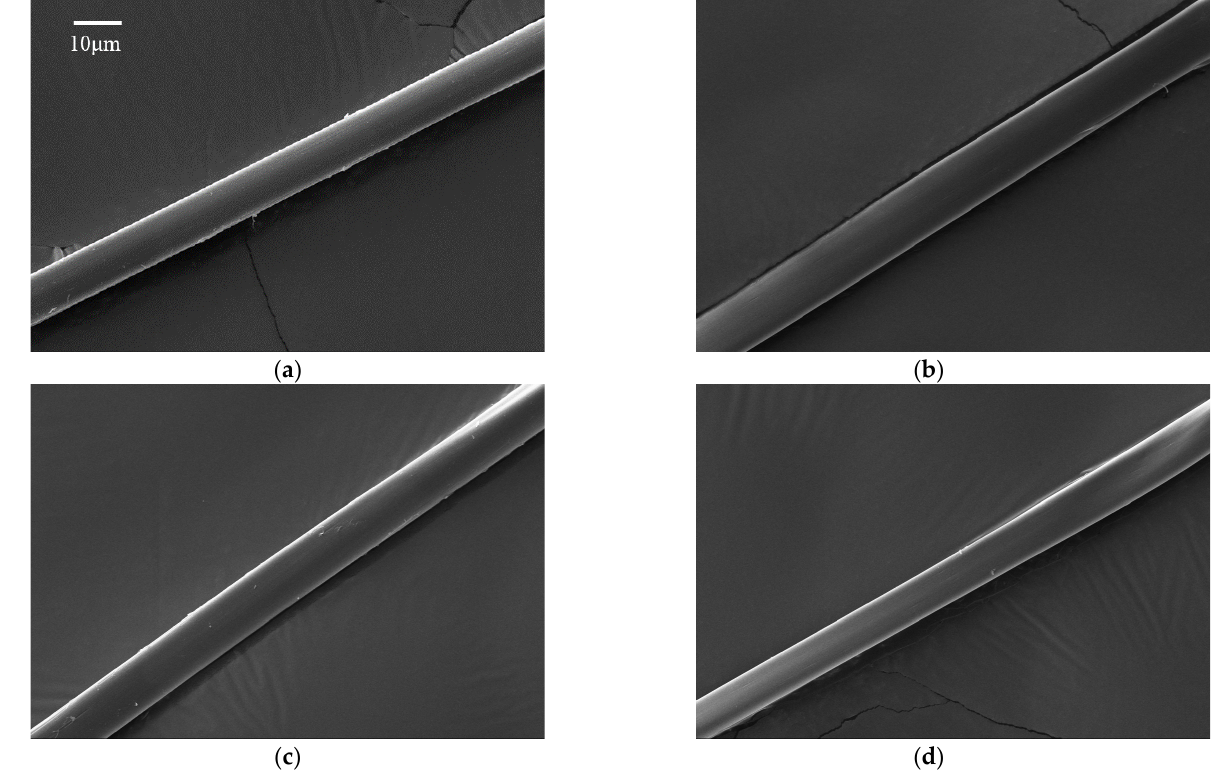
Figure 7. SEM images of silk fibroin fiber: ( a ) control, ( b ) CDs-0.25%, ( c ) CDs-0.50% and ( d ) CDs-0.75%.